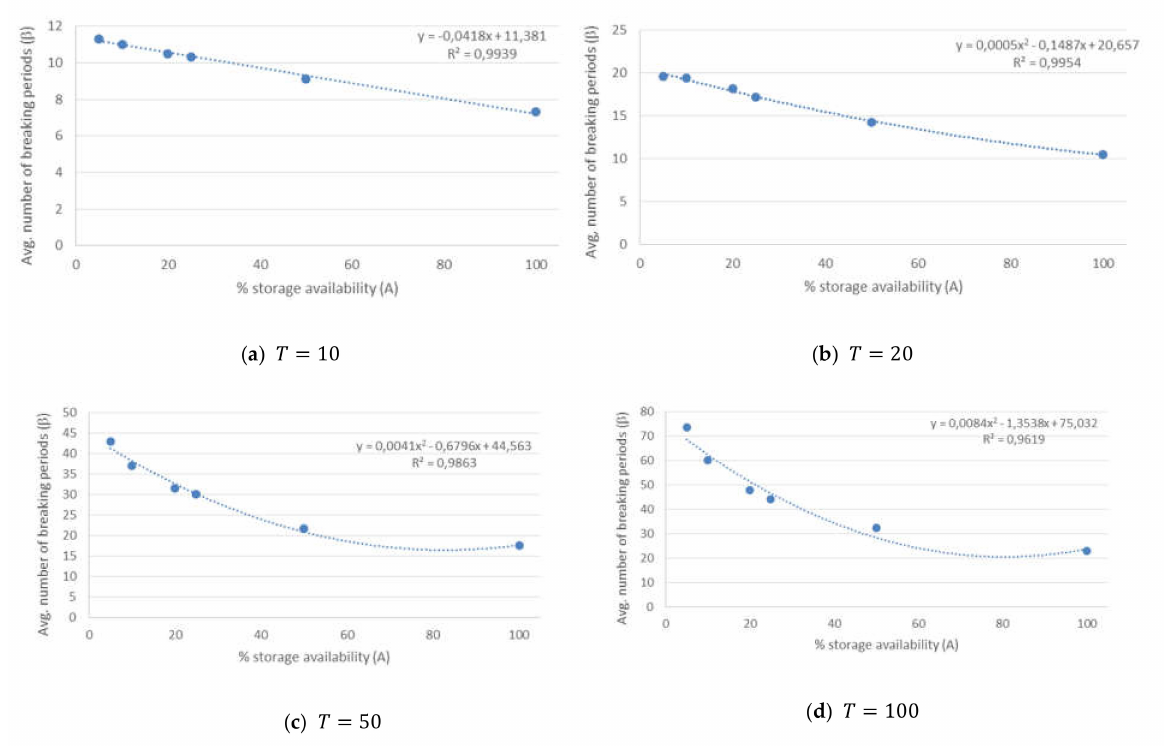
Figure 2. Average number of breaking periods ( β ) vs. the percentage of storage availability (A) for different values of